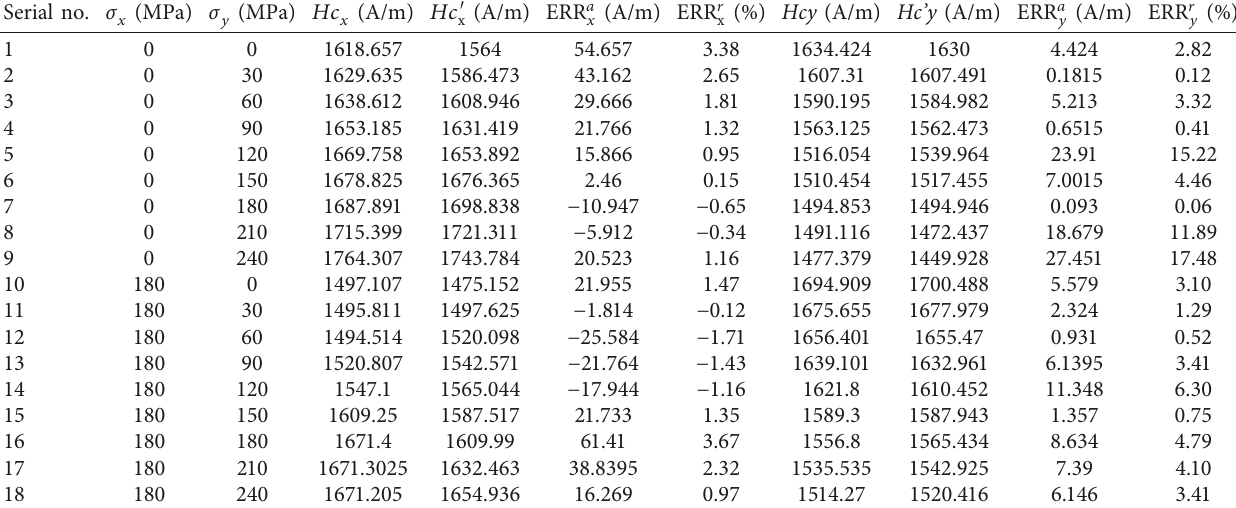
Table 3: Error analysis of fitting results of test piece